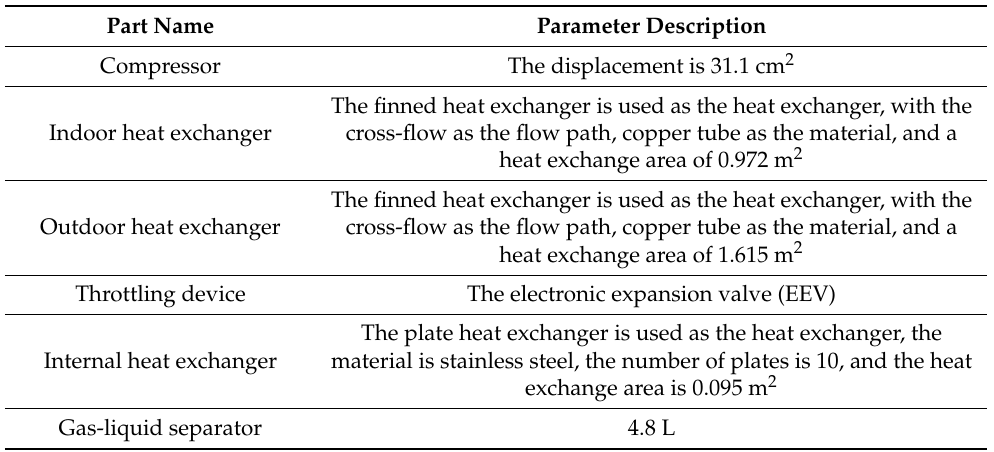
Figure 4. The experimental prototype of the transcritical CO 2 -based bus air conditioning/heat pump system. Table 1. Component parameters of the transcritical CO 2 -based bus air conditioning/heat pump system.